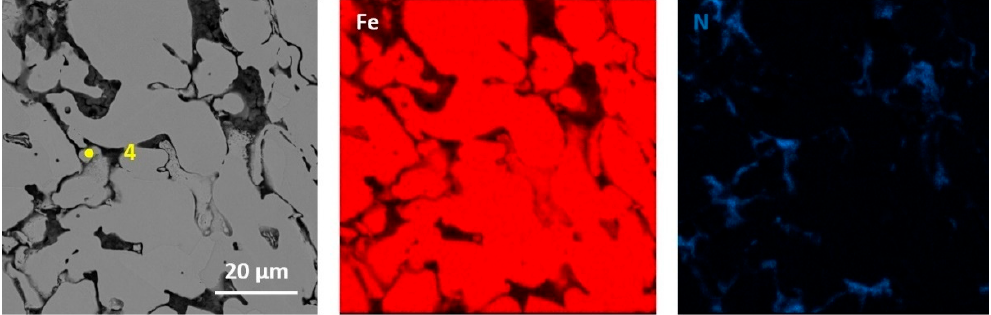
Figure 15. EDS mapping of sintered Fe with the addition of h-BN with a size of 1.5 μ m (for pressing pressure 350 MPa).